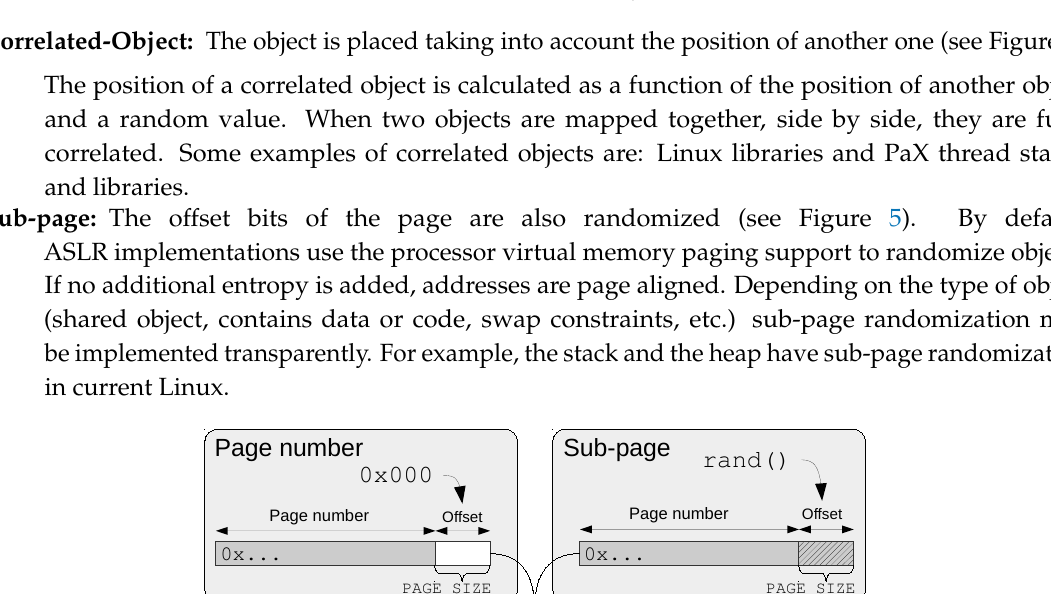
Figure 4. Correlated versus Isolated-object randomization.